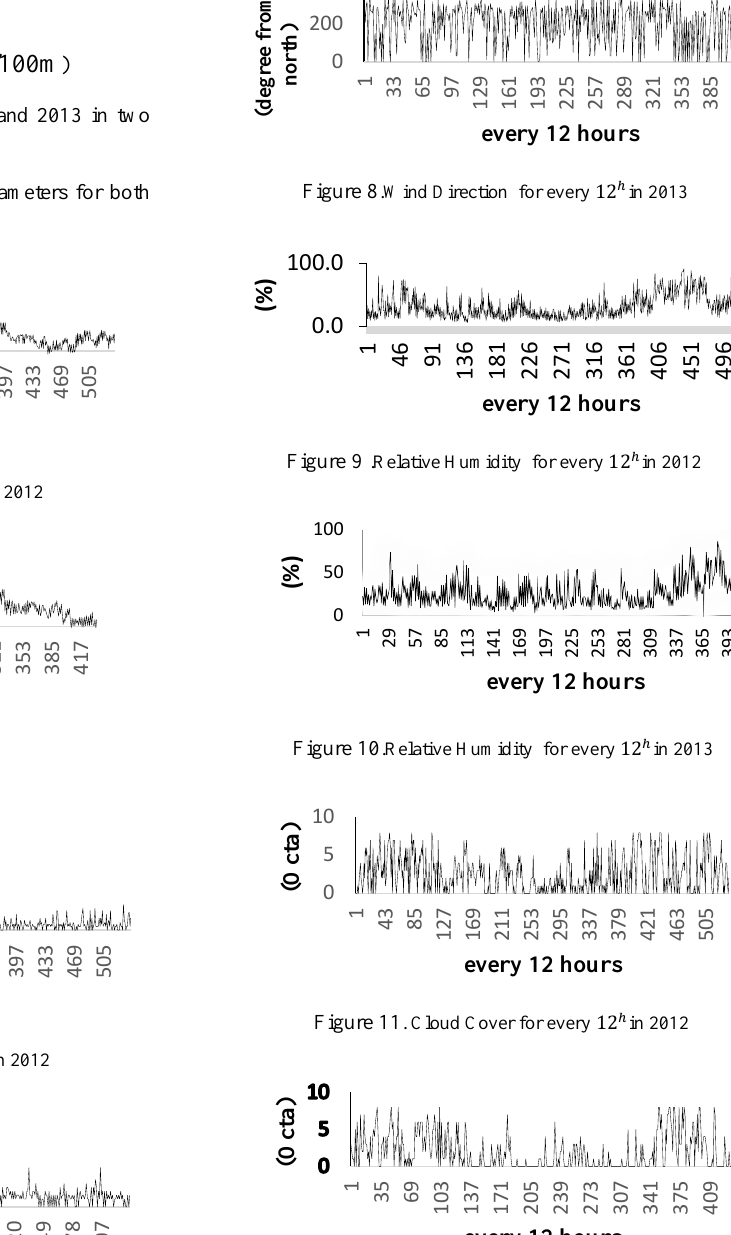
Figure 12 . Cloud Cover for every 12 ℎ in 2013